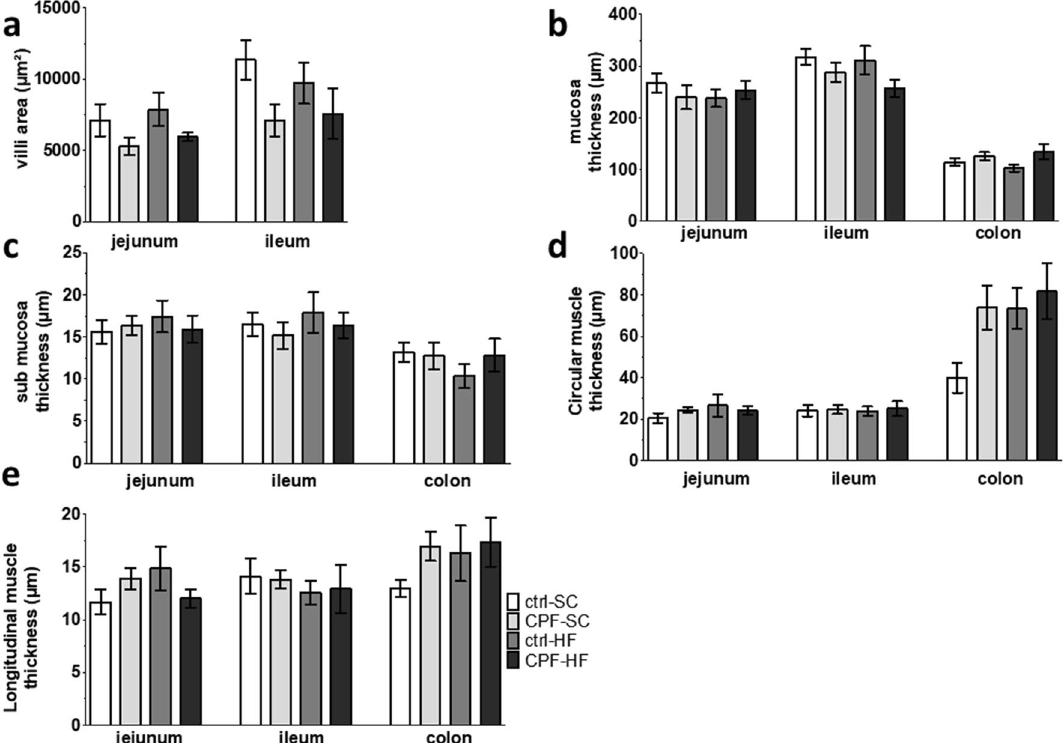
Figure 2. Histological measurements of digestive segments on male offspring at young adult age from CPF and/or HFD exposed mothers. ( a ) Villi area (µm 2 ), ( b ) Mucosa thickness (µm), ( c ) Submucosa thickness (µm), ( d ) Circular muscle thickness (µm), ( e ) Longitudinal muscle thickness (µm) in jejunal, ileal and proximal colon segments. Values are expressed as the mean ± SEM (n = 5) using the analysis of variance (ANOVA) and a subsequent post hoc Bonferroni test. ctrl control, CPF Chlorpyrifos, HF high fat, SC standard